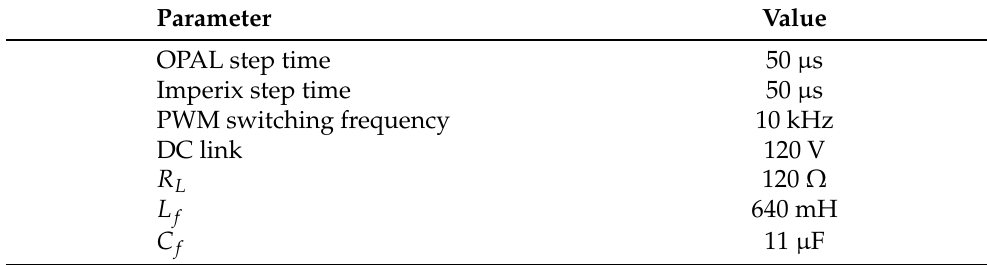
Table 5. Case Study system and simulation platforms’ parameters.